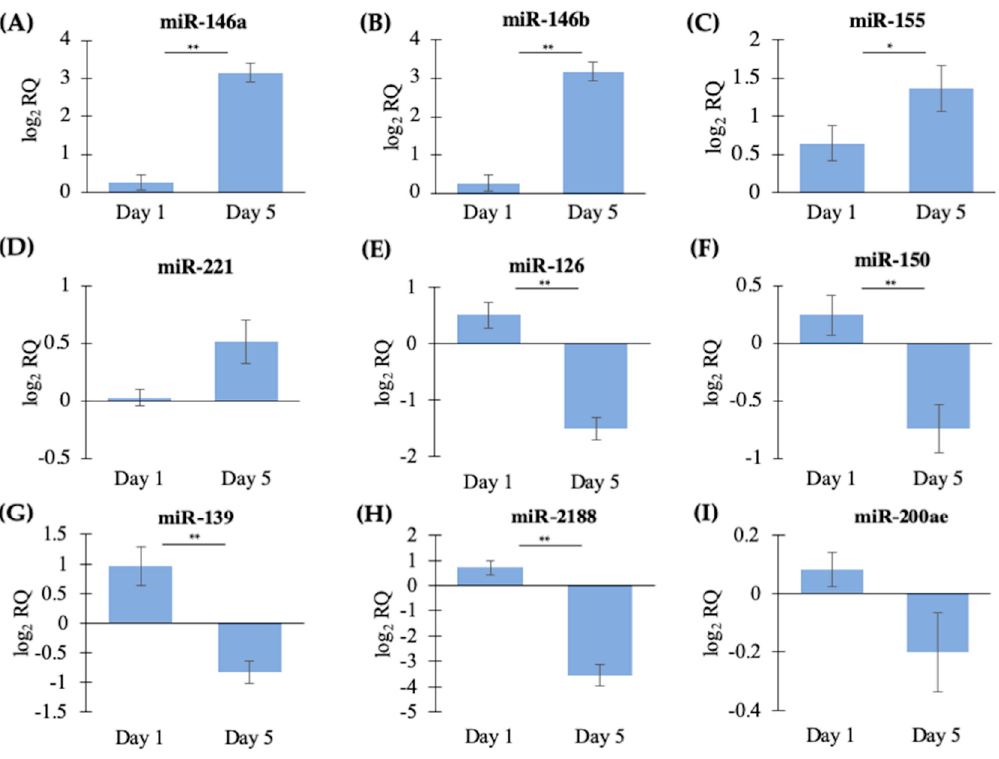
Figure 4. qPCR analysis of DE miRNAs identified by small RNA sequencing. Data shown as the mean log 2 relative quantity (RQ) ± SE., n = 5. Significance determined by a Student’s T -test, * p < 0.05 and ** p < 0.01. ( A ) miR-146a, ( B ) miR-146b, ( C ) miR-155, ( D ) miR-221, ( E ) miR-126, ( F ) miR-150, ( G ) miR-139, ( H ) miR-2188 and ( I ) miR-200ae. Table 2. Differentially expressed miRNAs identified by sequencing and validated by qPCR. Sequencing qPCR Sequencing qPCR Mature miRNA Base Mean